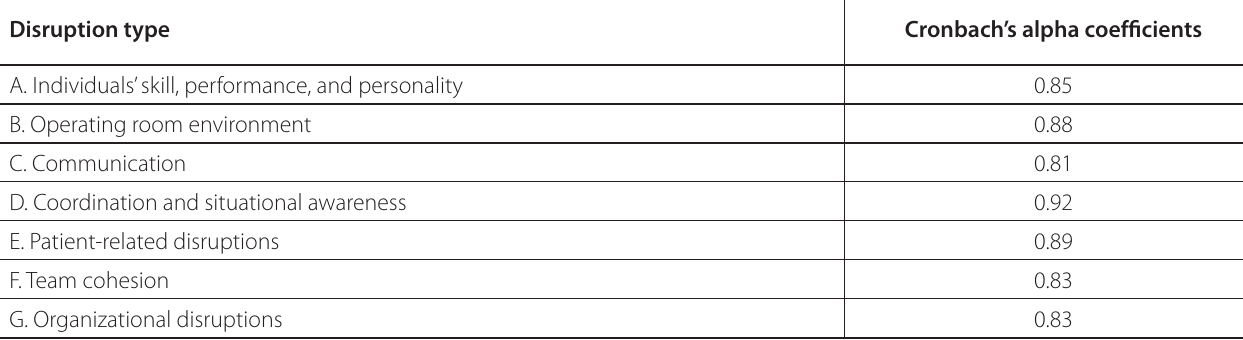
Table 2 . Reliability analyses of the disruption type